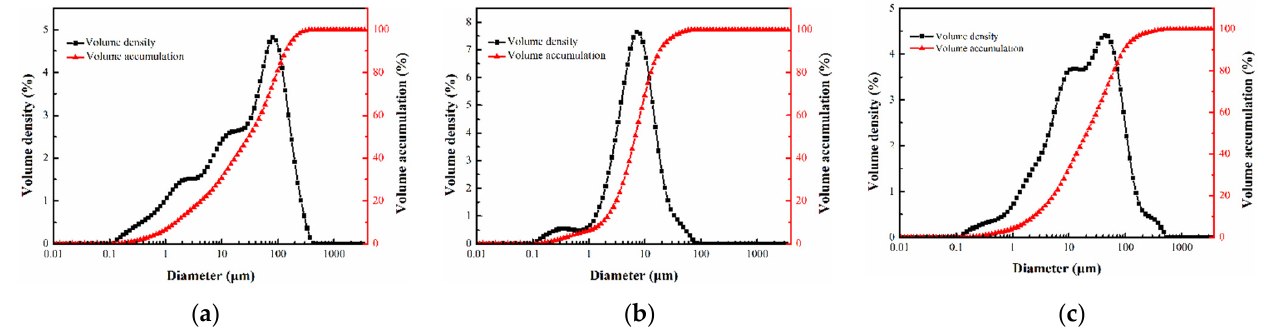
Figure 1. Particle size distributions of ( a ) sulfoaluminate cement clinker, ( b ) anhydrite, and ( c ) lime. Table 1. A chemical analysis of the sulfoaluminate cement clinker, anhydrite, and lime (wt%). Components